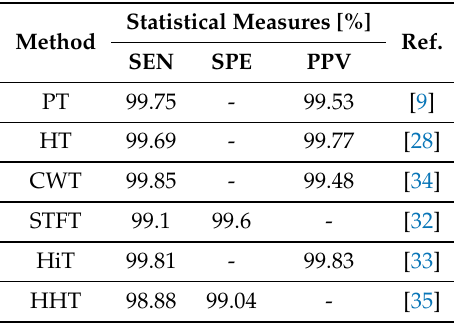
Table 2. Key QRS detection methods and statistical comparison of their performance over